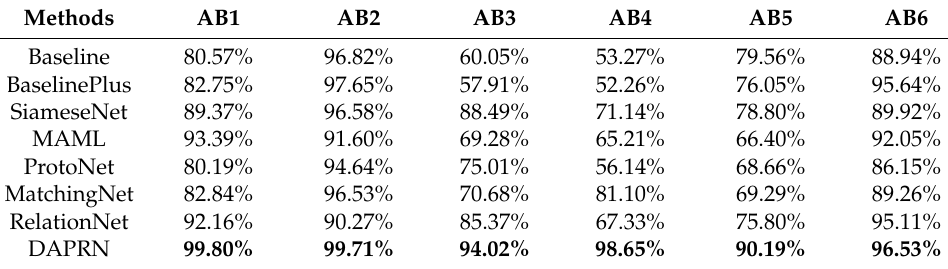
Table 10. Accuracy on one-shot fault diagnosis of transfer learning scenarios.